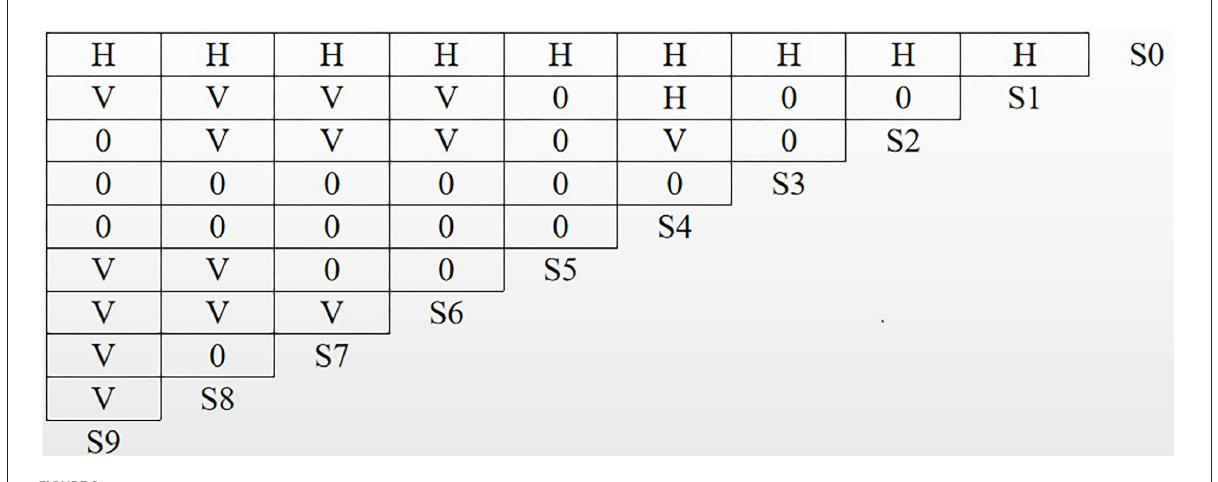
FIGURE2 Logical relationships of influencing factors.